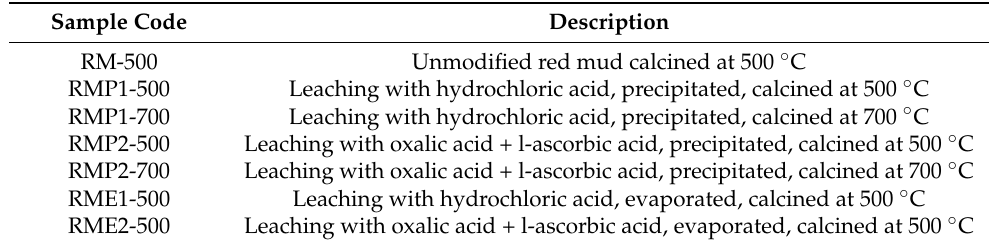
Table 9. Nomenclature of the prepared